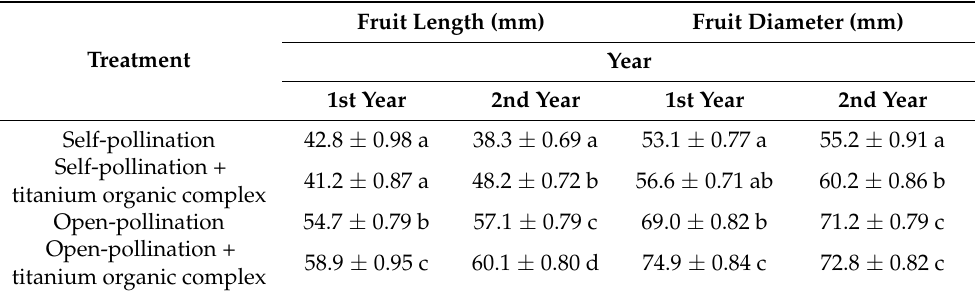
Table 3. The effect of titanium organic complex application on length and diameter of apple fruit